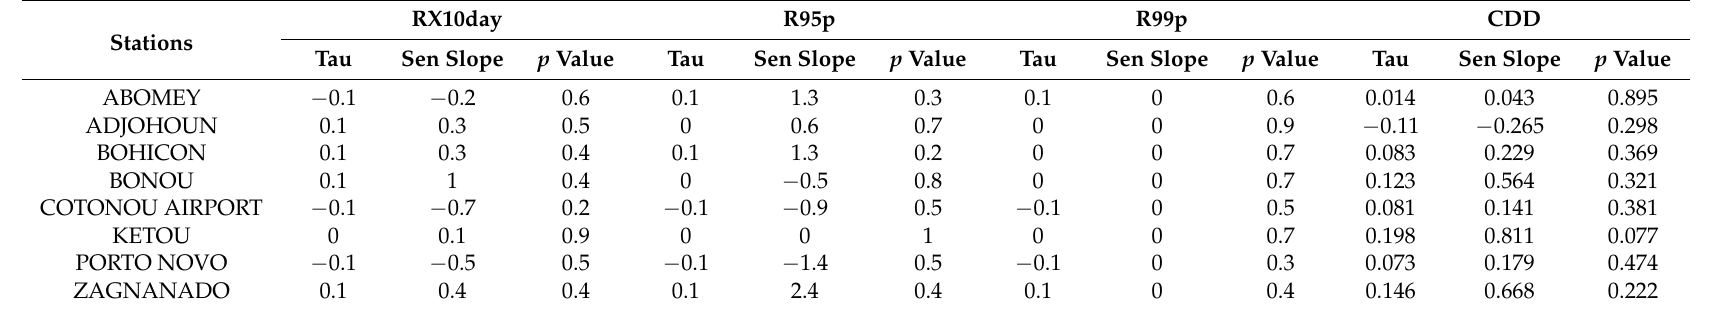
Table 6. Annual consecutive dry day (CDD), very wet day (R95p), and extremely wet day (R99p) indices trend with no